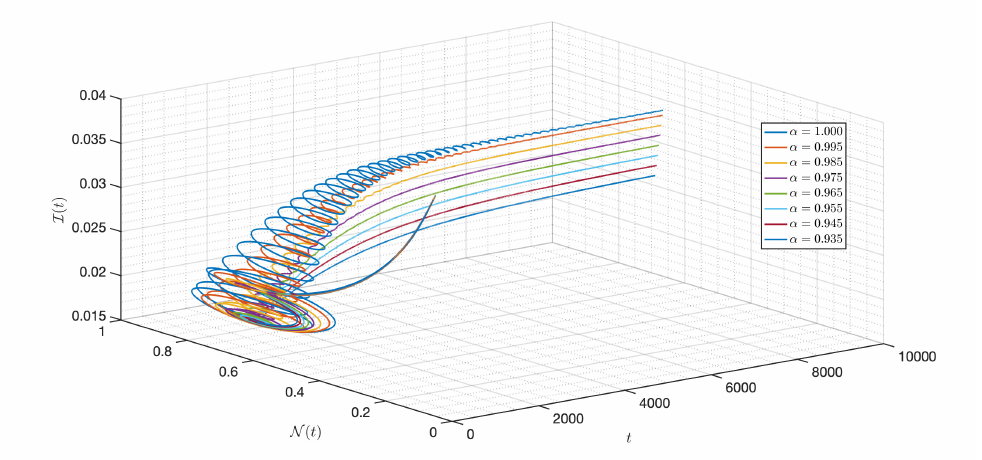
Figure 19. Dynamic of the model (3) for different parameters in Case II .